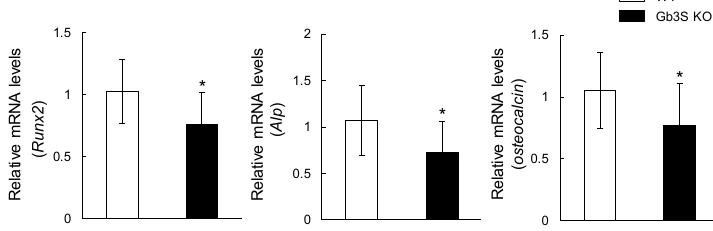
Figure 7. Suppression of gene expression of osteogenic differentiation markers ( Runx2 , Alp , and osteocalcin) by Gb3 synthase deficiency. RNA isolated from femur and tibia in 15-week-old mice (male, n = 12 for WT, n = 12 for Gb3S KO). Data are expressed as mean ± S.D. The single asterisk indicates p < 0.05.